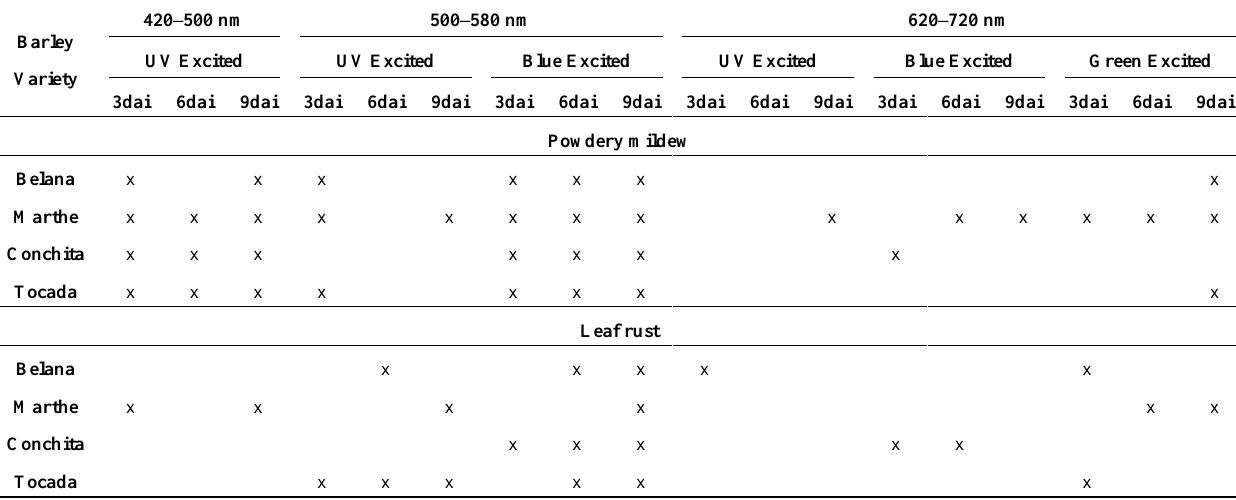
Table 2. Temporal development of the blue (420–500 nm), green (500–580 nm) and ChlF (620–720 nm) for mildewed and rust infected spring barley leaves of the varieties Belana, Marthe, Conchita and Tocada. (x) indicates significant differences between control and pathogen inoculated leaves ( t -test, p ≤